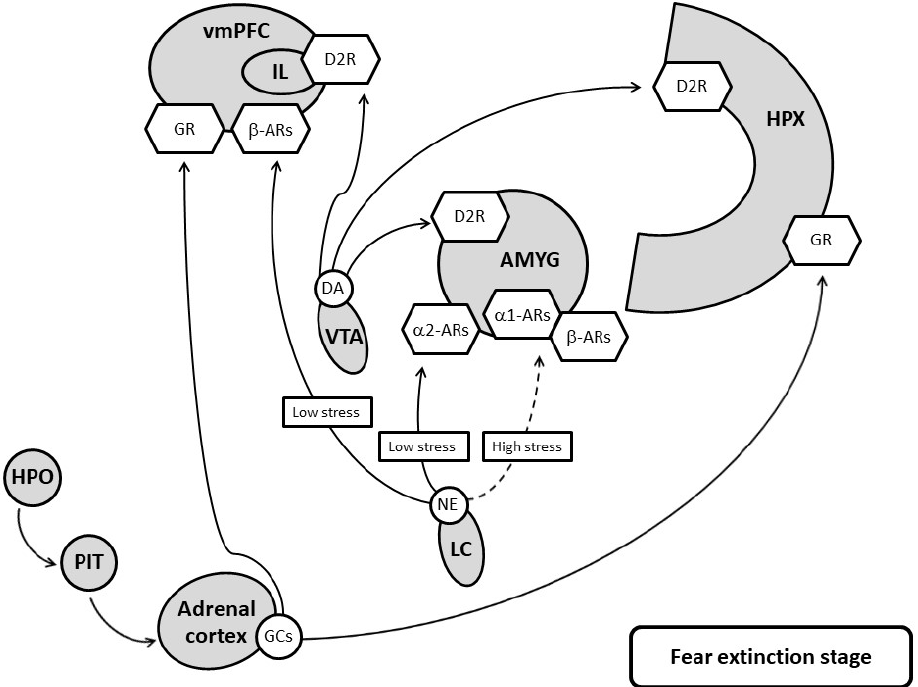
Figure 2. The regulations of fear extinction by neurochemicals in the fear circuit. DA, NE and glucocorticoids contribute to fear deconditioning through their corresponding receptors, but NE disrupts fear deconditioning when under extreme stress. vmPFC: ventral medial prefrontal cortex; IL: infralimbic cortex; HPX: hippocampus; AMYG: amygdala; VTA: ventral tegmentum area; LC: locus coeruleus; RN: raphe nucleus; HPO: hypothalamus; PIT: pituitary; NA: noradrenaline; α 1-ARs: α 1 NA receptors; α 2-ARs: α 2 NA receptors; β -ARs: β NA receptors; DA: dopamine; D1R: D1 receptors; D2R: D2 receptors; GCs: glucocorticoids; GR: glucocorticoid receptor. The solid line refers to the strengthening of fear extinction, the dashed line refers to the weakening of fear extinction.